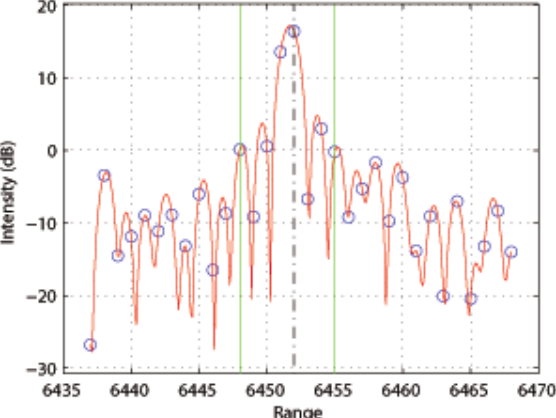
Figure 5. Corner reflector HH response (in range expressed in pixel numbers).